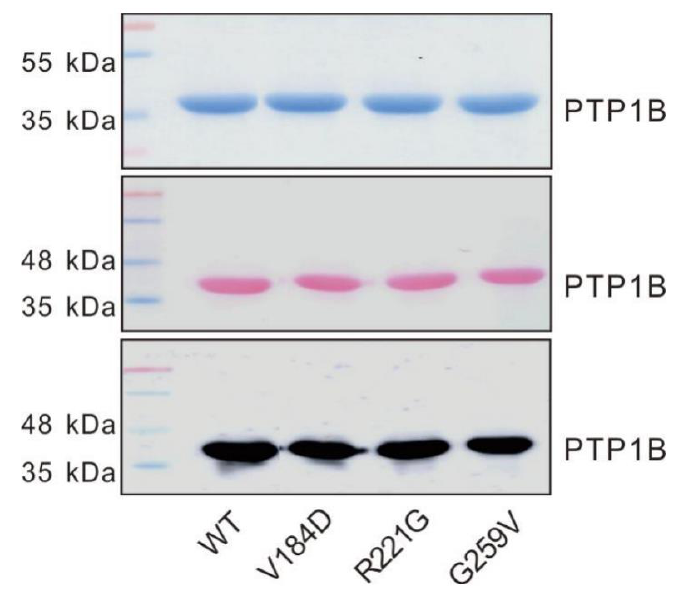
Figure 1. Purification of the PTP1B proteins in the WT and mutants. These PTP1B proteins were separated by SDS-PAGE post-purification and stained using Coomassie dye or further transferred onto nitrocellulose membrane for PTP1B immunodetection following Ponceau staining. To assess the intrinsic protein tyrosine phosphatase activity of WT PTP1B and the three mutants, we carried out reverse-phase ultra-fast liquid chromatography (RP-UFLC) using a known tyrosine-phosphorylated peptide substrate of PTP1B (sequence: KGTGYphosphoIKTE) derived from human STAT1 as previously described [28,29]. Compared to WT PTP1B, the intrinsic protein tyrosine phosphatase activity of the three mu- tants was found to be extremely low; the V184D mutant displayed around 5% residual activity, and the R221G and G259V mutants were almost inactive (Figure 2A).